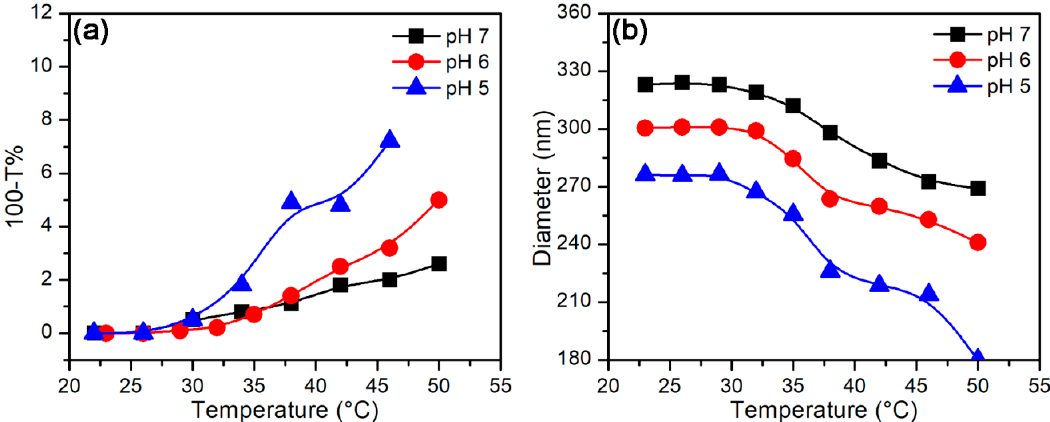
Figure 7. Effect of temperature on protein adsorption in PSV@PNIPA- b -PAA at various pH values via ( a ) turbidity and ( b ) hydrodynamic diameter change.